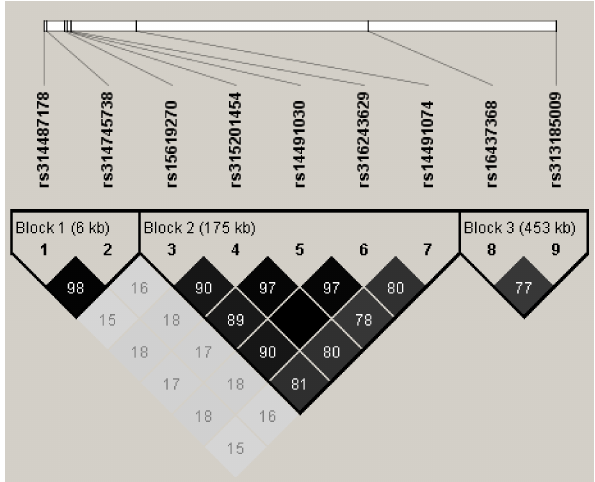
Figure 3. LD analysis of the significant SNPs on GGA4. Three strong blocks were observed in this significant region, number in the diamond block is the R 2